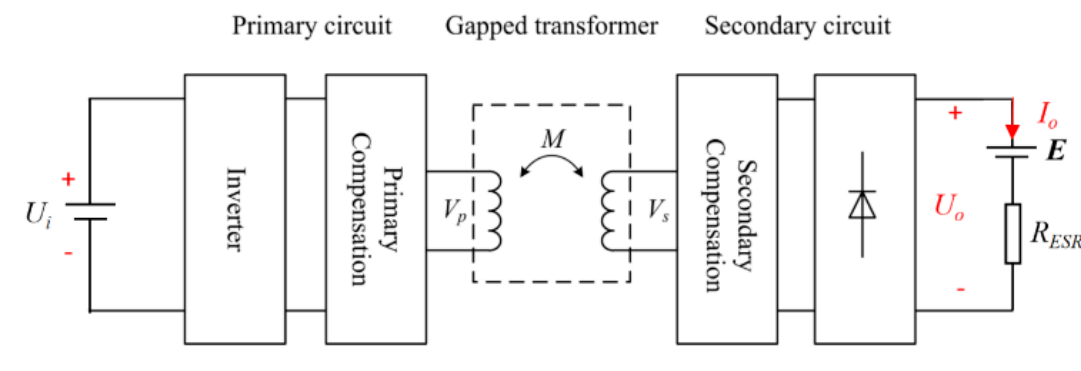
Figure 2. Typical diagram of inductive charging system.